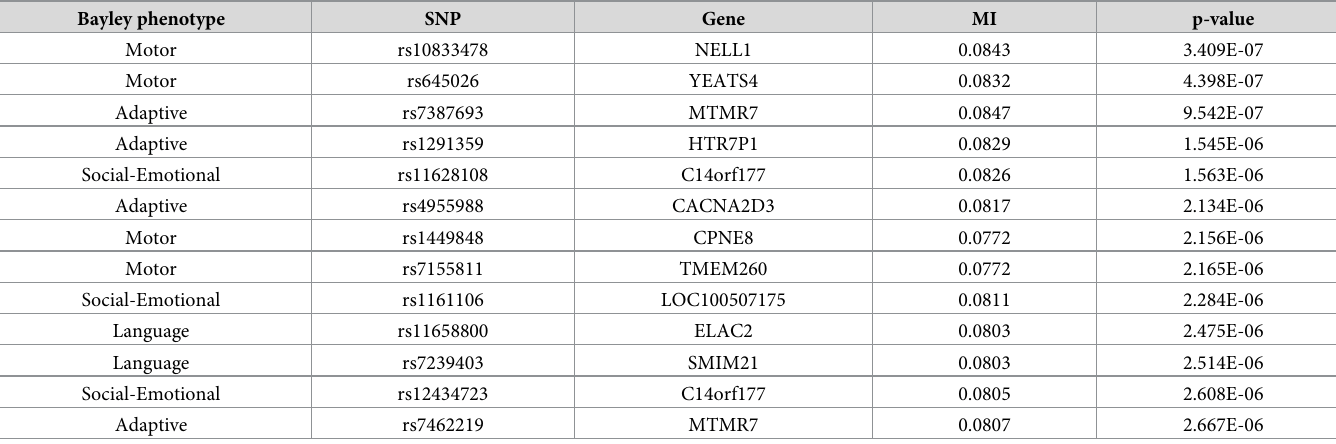
Table 2. Significant SNPs associated with Bayley phenotypes using two-way dependency measures (mutual information, MI). Bayley